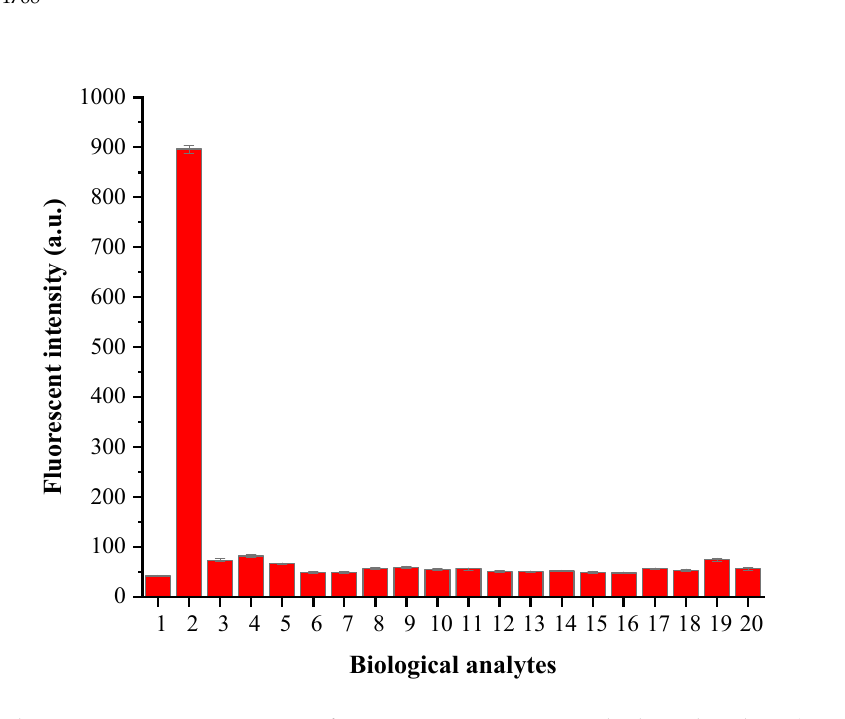
Figure 5. Fluorescent intensity responses of 10 µ M YZ-A4 at 614 nm to biological analytes (100 µ M) in PBS (10 mM, pH 7.40, containing 1% DMSO as cosolvent). Legend: (1) Blank; (2) Sec; (3) Cys; (4) Hcy; (5) GSH; (6) Glu; (7) Asp; (8) Val; (9) Phe; (10) Pro; (11) Thr; (12) Arg; (13) Lso; (14) Leu; (15) His; (16) Lys; (17) Try; (18) Ser; (19) Na 2 Se; (20) Na 2 SeO 3 . Excitation at 550 nm. Each piece of data was obtained 3 min after mixing.